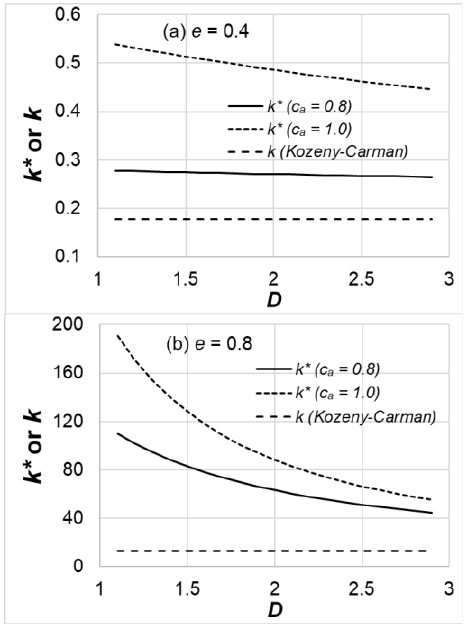
Figure 5. The influence of fractal dimension D on the mean dimensionless permeability k* for ( a ) e = 0.4 and ( b ) e = 0.8. The k result from the KC equation, which is a horizontal line, is also plotted for comparison.